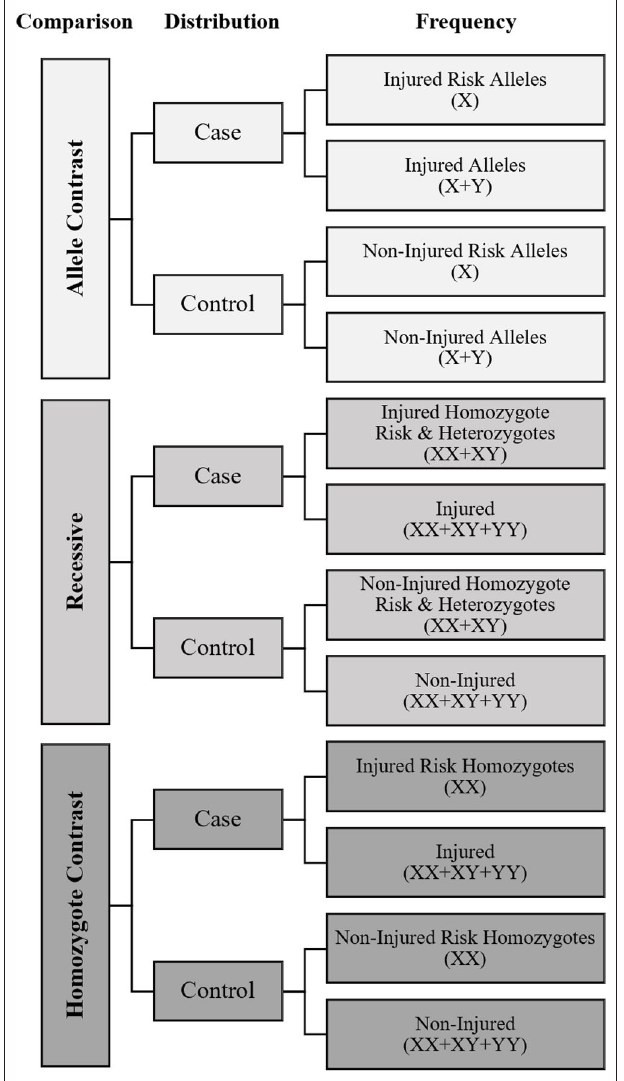
FIGURE 1 | Meta-Analysis data input diagram . X, Risk Allele of genetic variant for fracture as defined by mechanistic rationale or candidate gene association study; Y , Non-Risk Allele of genetic variant. Symbols in parentheses indicate how the frequency counts were calculated to establish if differences in the risk allele distribution were present between cases and controls for each